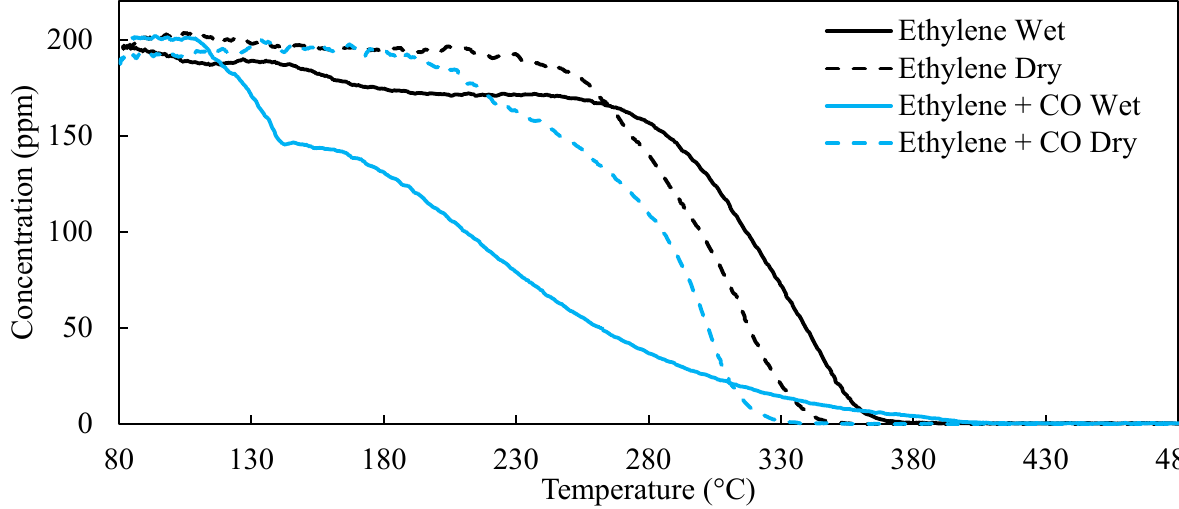
Figure 4. Ethylene conversion during a temperature ramp with and without CO under wet and dry conditions (200 ppm ethylene, 0 or 500 ppm CO, 0 or 6% H 2 O, 12% O 2 , balance N 2 ).